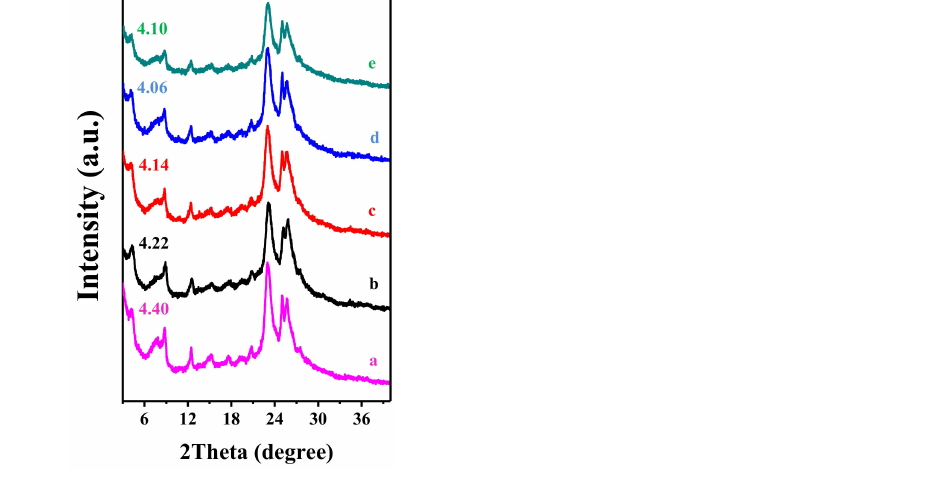
Figure 4. XRD patterns of ( a ) as-synthesized COK-5, ( b ) IEZ-COK-5-0, ( c ) IEZ-COK-0.185, ( d ) IEZ- COK-0.375, and ( e ) IEZ-COK-0.830. Reprinted with permission from ref. [40]. Copyright 2015,